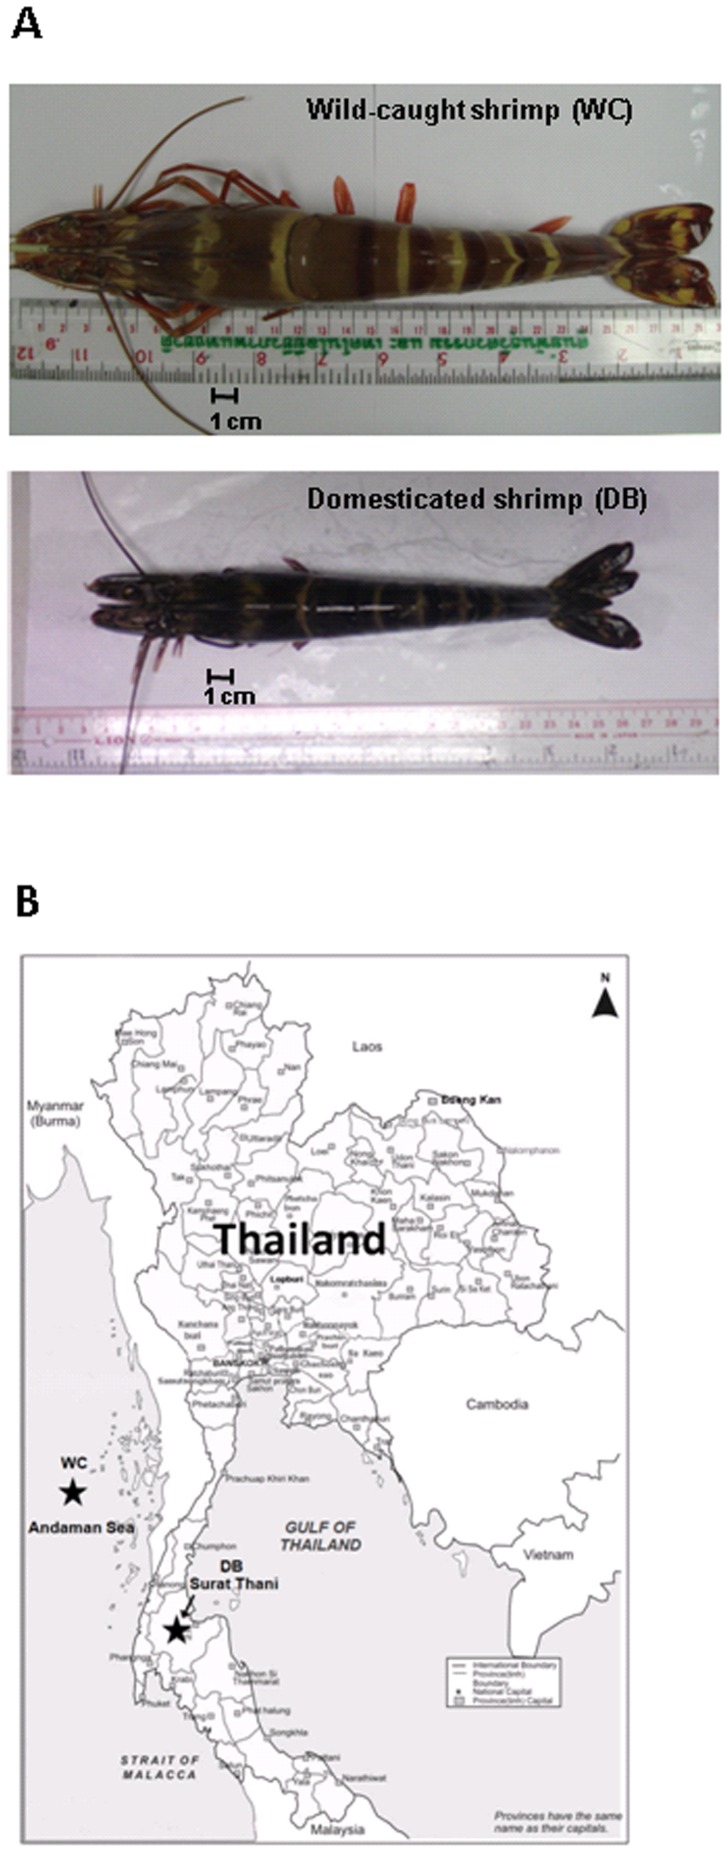

Penaeus monodon from wild and domesticated habitats (A).Wild-caught P. monodon adults (WC) were captured from the Andaman Sea, whereas 10-month-old domesticated adults (DB) were reared at the Shrimp Genetic Improvement Center, Surat Thani, Thailand (B). The map was adapted from http://www.mapsofworld.com/thailand/thailand-political-map.html.